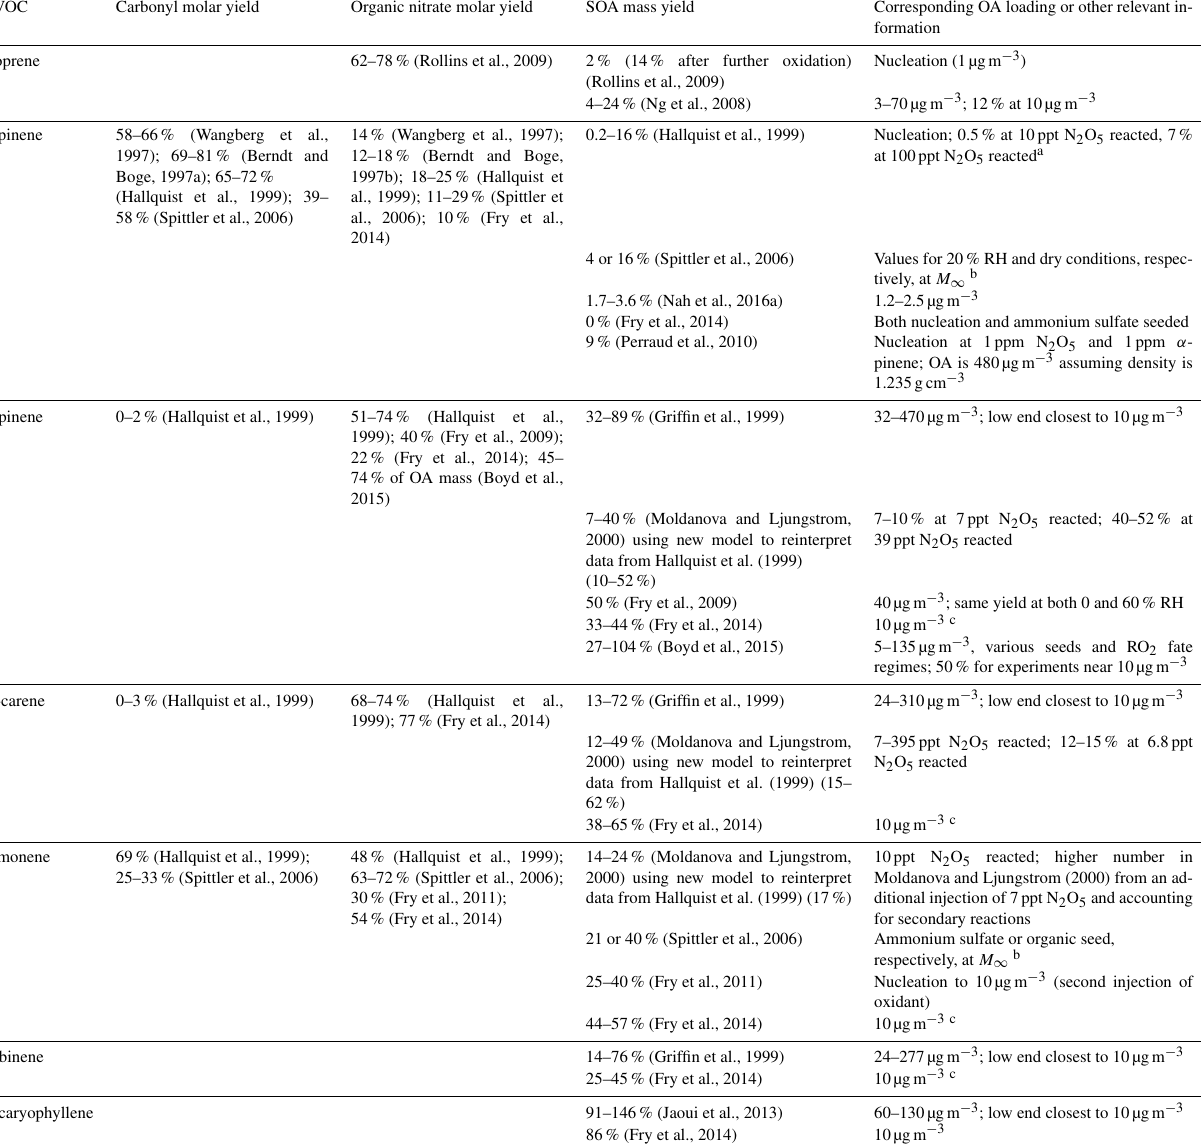
Table 2. Oxidation products and SOA yields observed in previous studies of NO 3 -BVOC reactions. Except where noted, carbonyl and organic nitrate molar yields represent initial gas-phase yields measured by FTIR spectroscopy (carbonyl and organic nitrate) or thermal desorption laser-induced fluorescence (TD-LIF) (organic nitrate only; Rollins et al., 2010; Fry et al., 2013). In some cases, the ranges reported correspond to wide ranges of organic aerosol loading, listed in the rightmost column. Where possible, the mass yield at 10µgm − 3 is reported for ease of